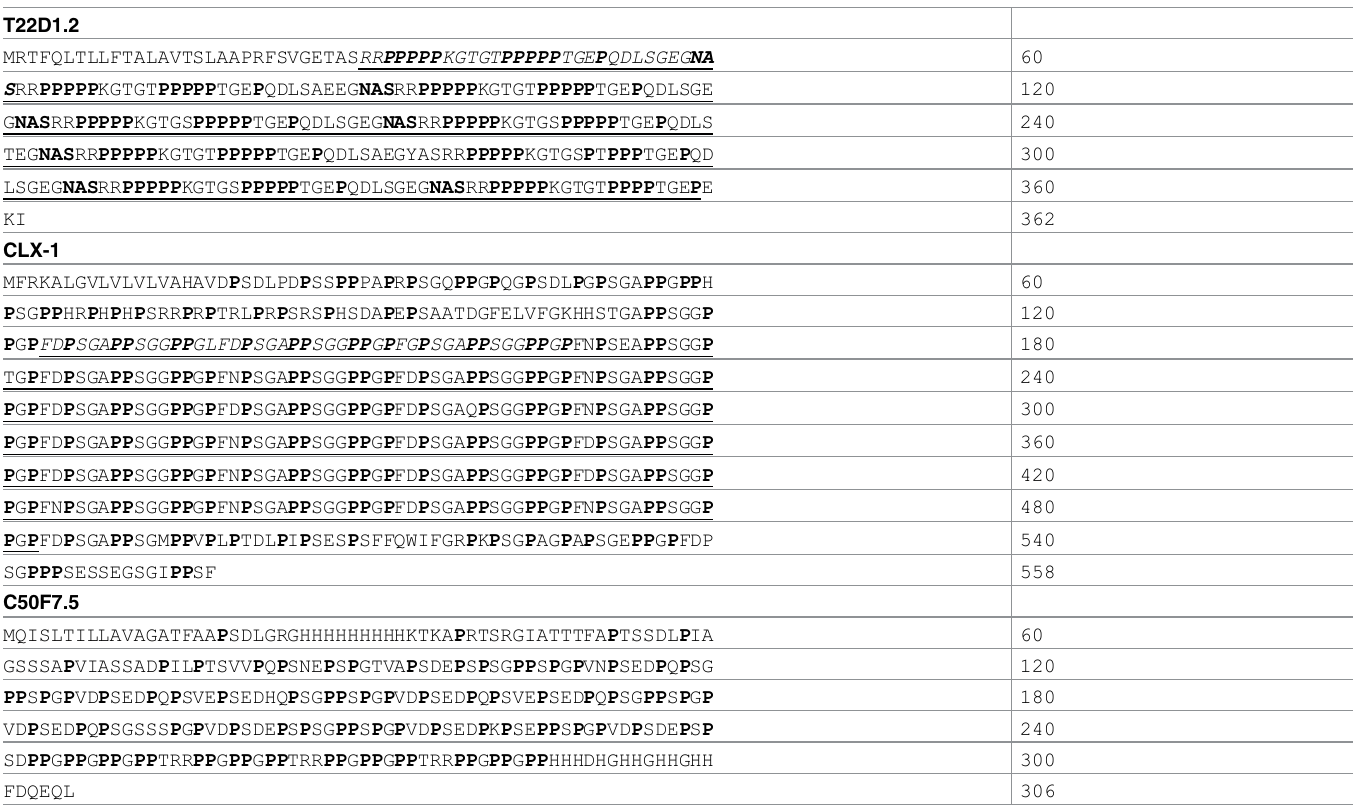
Table 3. Predicted protein sequences of T22D1.2, clx-1 and C50F7.5. T22D1.2 MRTFQLTLLFTALAVTSLAAPRFSVGETAS RR PPPPP KGTGT PPPPP TGE P QDLSGEG